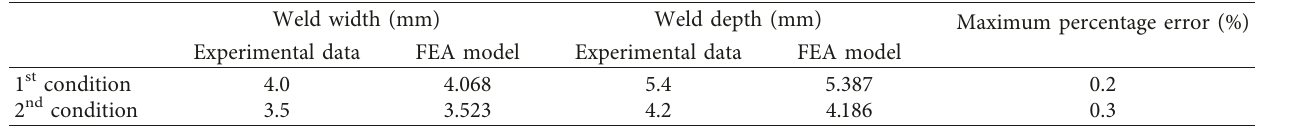
Figure 6: The heat source model collation: the collation under the (a) 1 st and (b) 2 nd welding conditions. Table 5: The percentage error between the simulated and actual molten